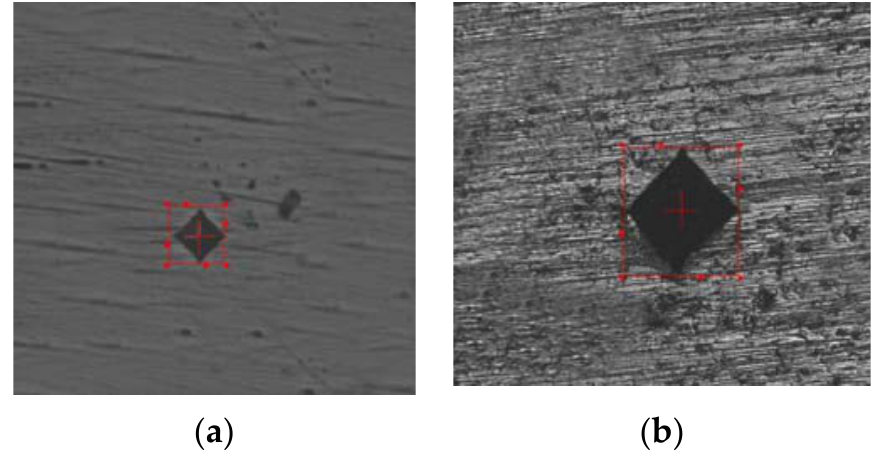
Figure 9. Indentation images of the sintered part: ( a ) LTCC and ( b ) copper.